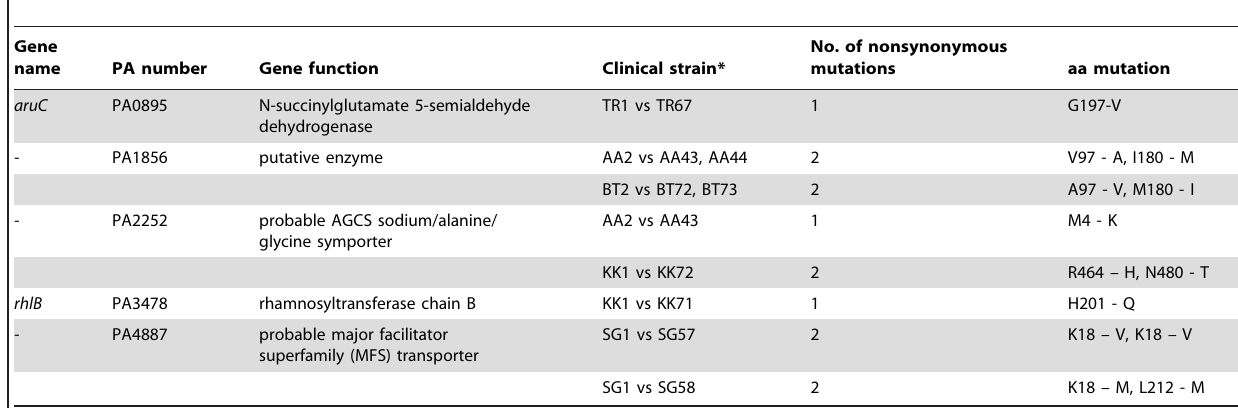
Table 2. Gene sequence comparison between early and late P. aeruginosa isolates from CF